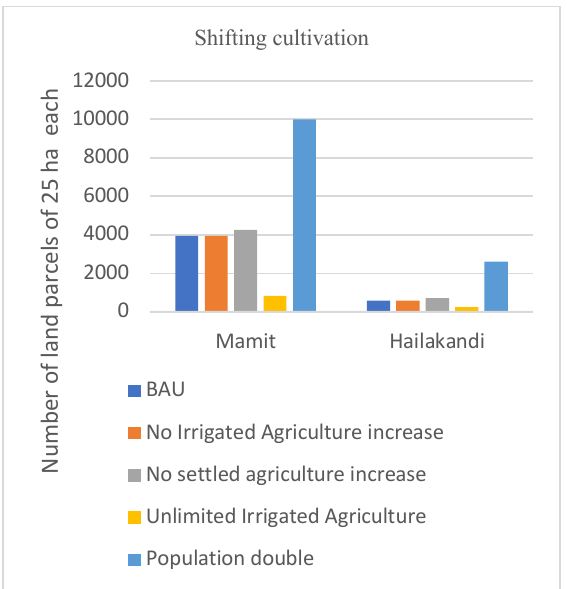
Figure 10. Changes in shifting cultivation over different scenarios